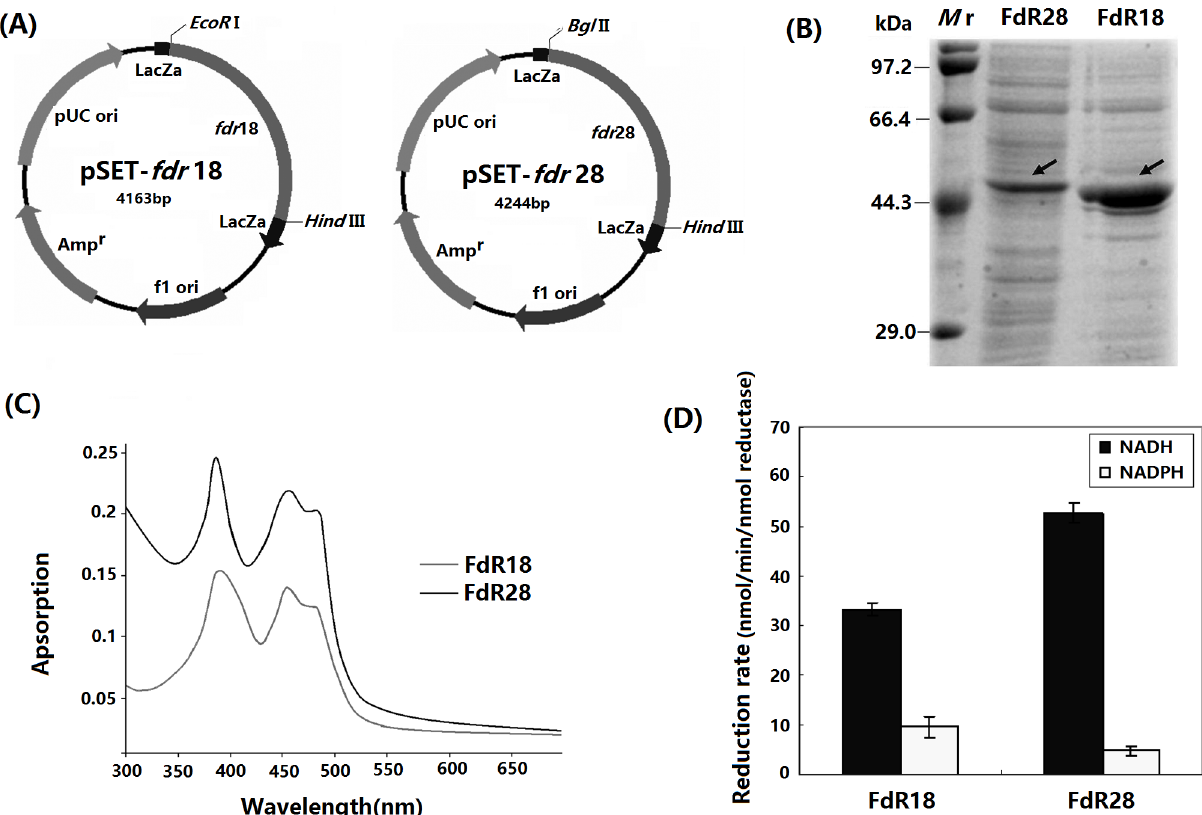
Figure 4. Expression and characterization of FdR18 and FdR28. (A) Recombinant expression vectors pRSET- fdr 18 and pRSET- fdr 28. (B) SDS- PAGE analysis of recombinant proteins FdR18 and FdR28 expressed by E. coli BL21 (DE3). Mr: protein markers. (C) UV-visible spectra of purified FdR18 and FdR28. Spectra were recorded at ambient temperature in 50 mM Tris buffer (pH 7.5). (D) DCPIP reduction activities of purified FdR18 and FdR28, measured in the presence of 200 uM NADH ( & ) or NADPH ( %